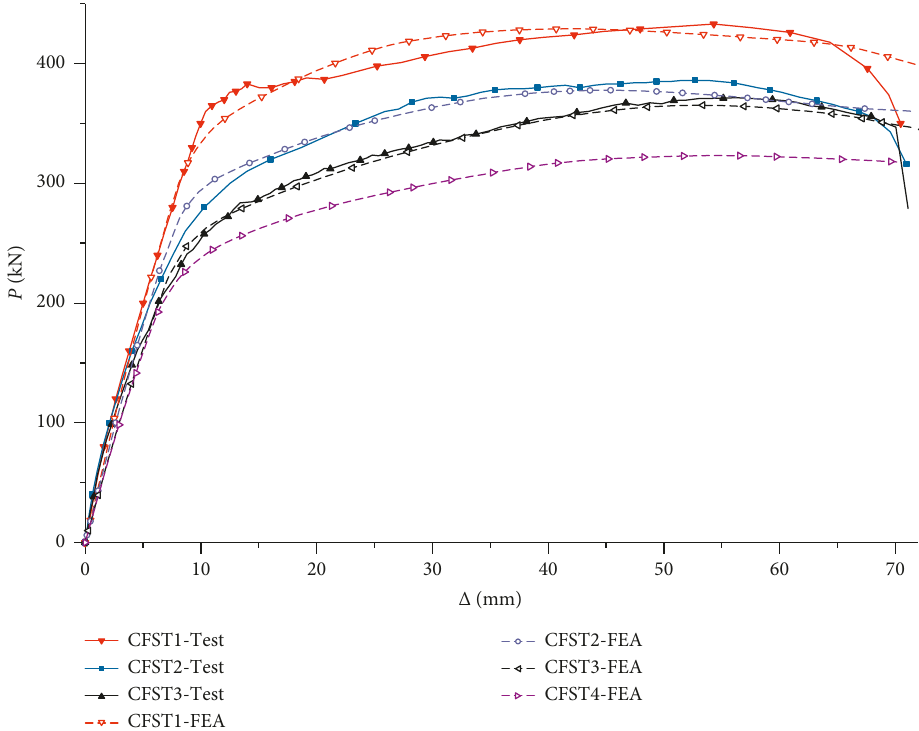
Figure 8: Comparison of FE analysis and experimental beam-tip force-displacement